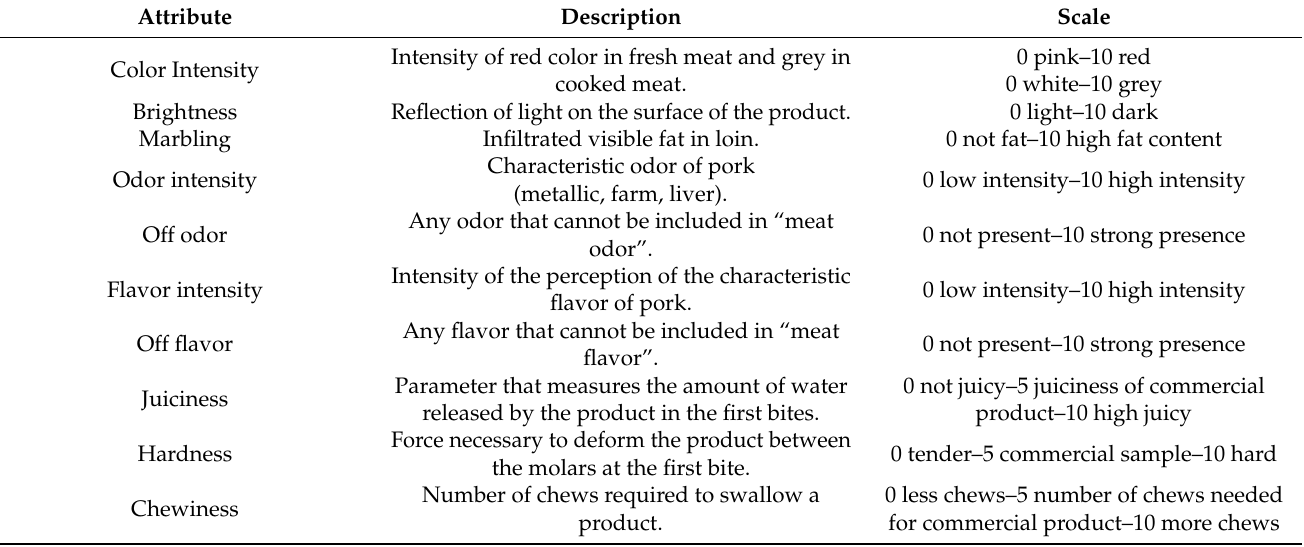
Table 2. Attributes used in sensory